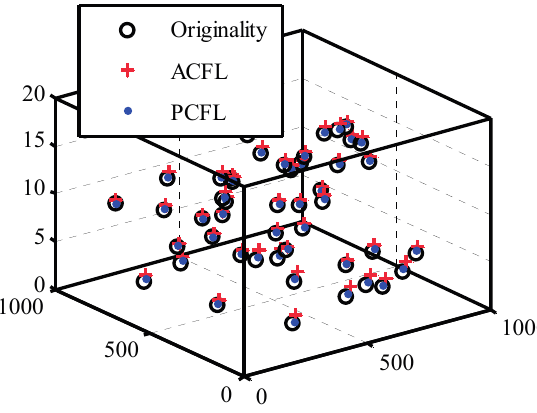
Figure 8. The original and estimated coordinates.